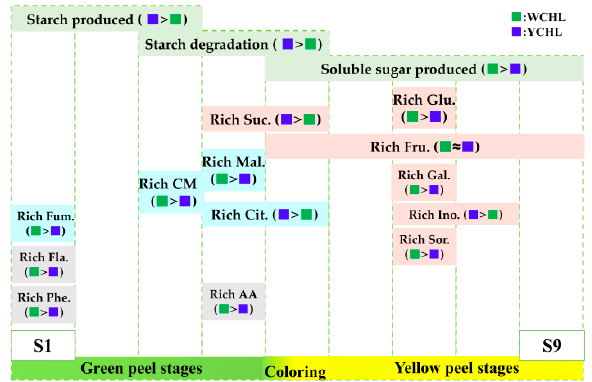
Figure 10. Schematic representation of sugar and organic acid metabolites during fruit developmental stages in two yellow-peel pitayas. Phe: phenolic; Fla: flavonoid; AA: ascorbic acid; Glu: glucose; Suc: sucrose; Fru: fructose; Gal: galactose; Ino: inositol; Sor: sorbitol; Mal: malic; Cit: citric; CM: citromalic; Fum: fumaric.